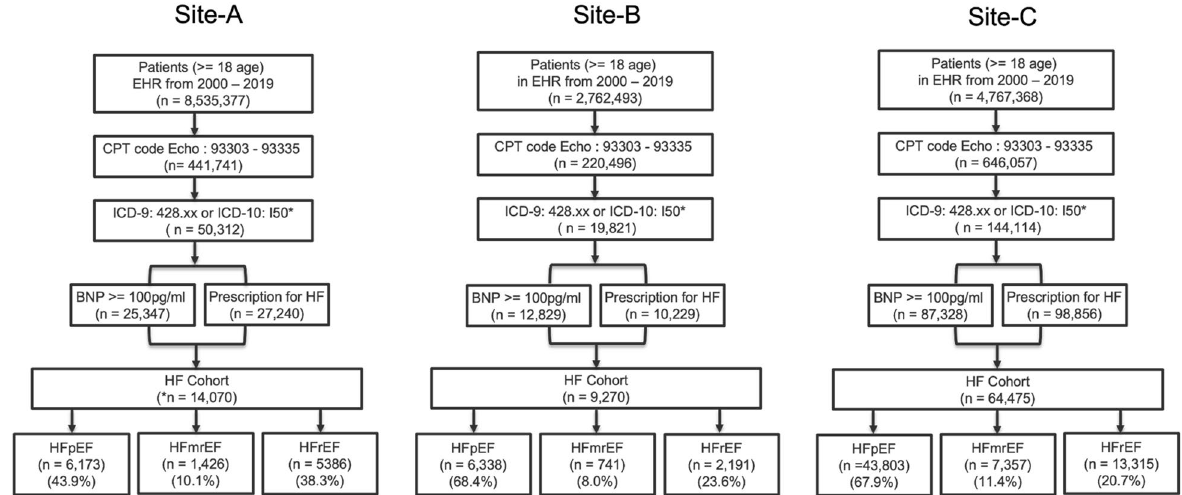
Figure 1. Heart failure subphenotypes at the three sites. For Site-A there were 1085 (7.7%) patients with no EF values